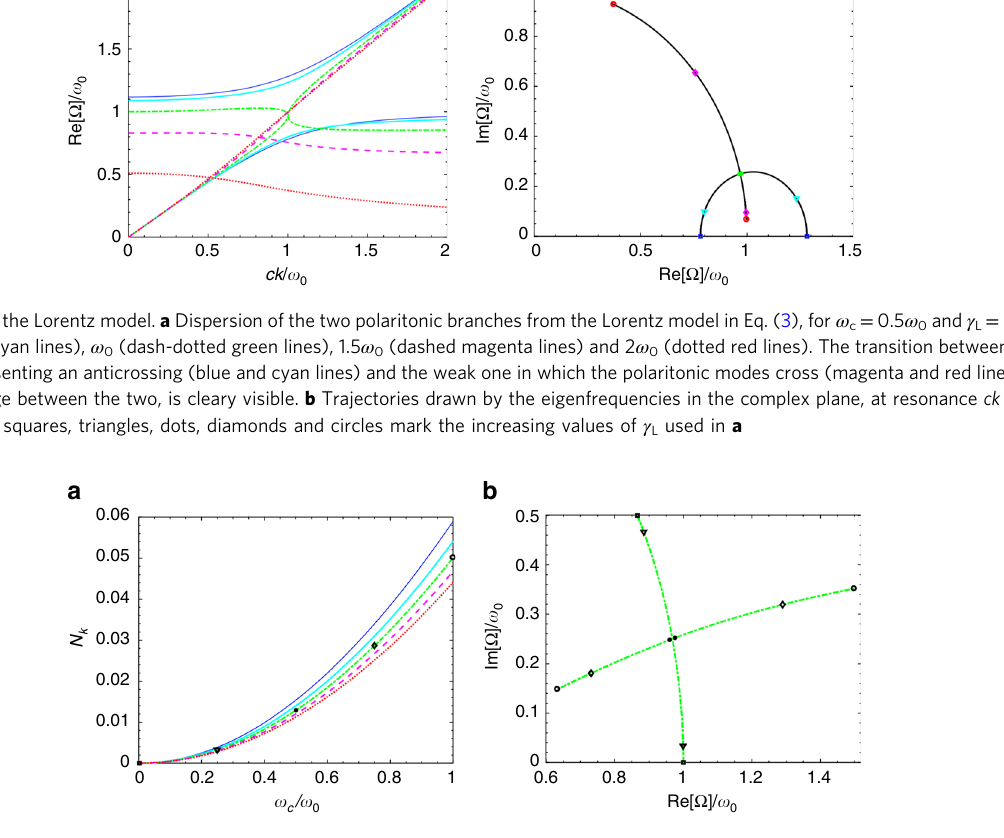
ffiffiffiffiffiffiffiffiffiffiffi p (cid:2) i γ ± 4 ω 2 0 (cid:2) γ 2 L L , corresponding to the 2